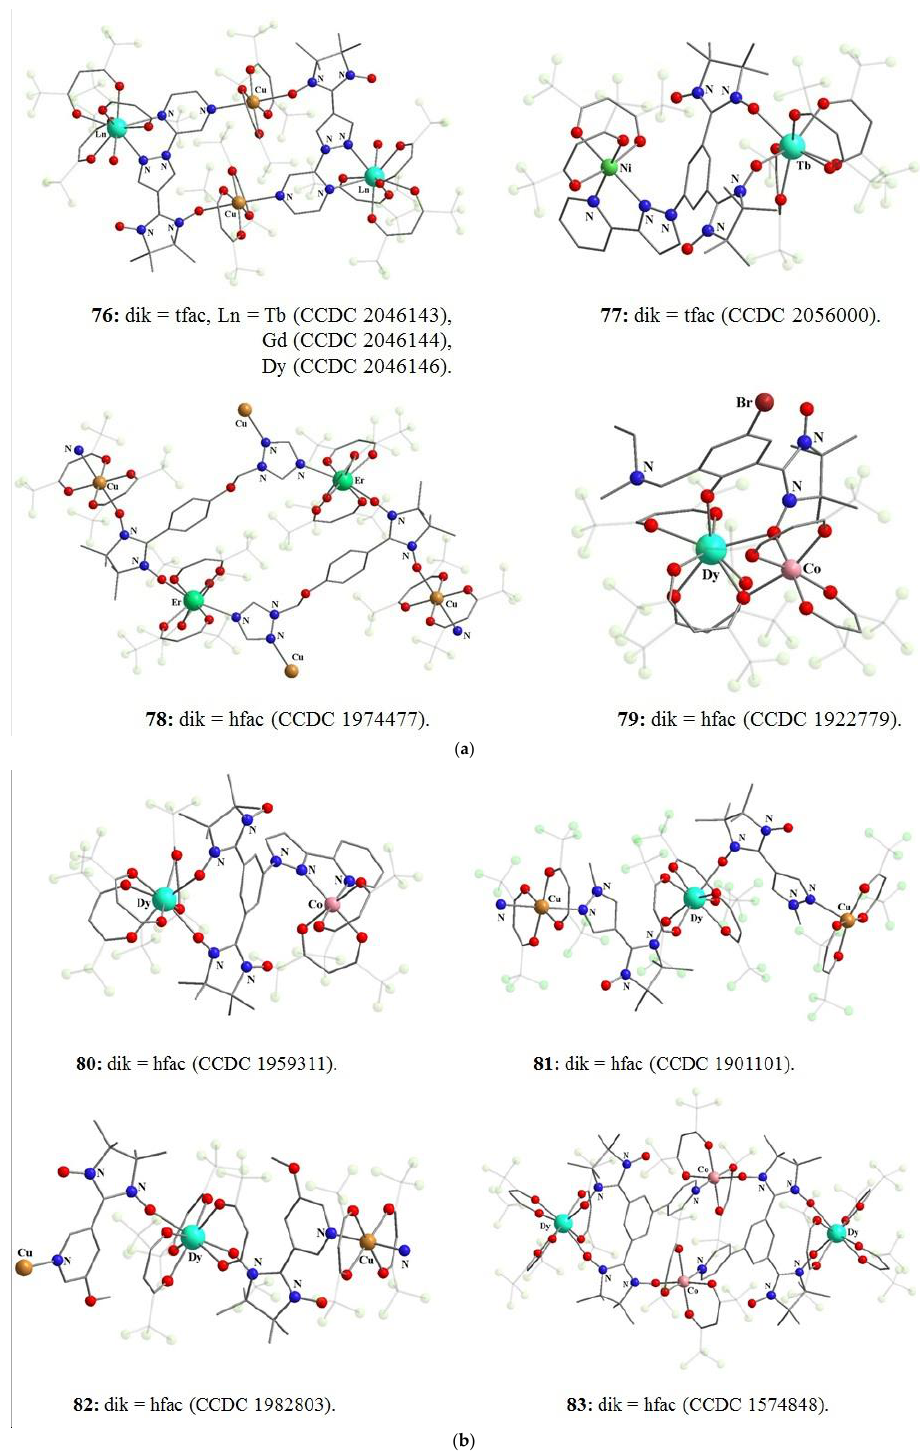
Figure 37. ( a )The examples of 3d/4f complexes containing Ln(III) tris - β -diketonate fragments. CF 3 groups are transparent for clarity. The cif has been retrieved from CCDC. ( b ) The examples of 3d/4f complexes containing Ln(III) tris - β -diketonate fragments. CF 3 groups are transparent for clarity. The cif has been retrieved from CCDC [113 – 119]. 11. Heterometallic Complex Synthesis Based on hfac Transformations In general, the synthesis of mono- and polynuclear β -diketonates is realized under basic conditions to facilitate the coordination with metal ions via deprotonation of the initial β -dicarbonyl compounds. Along with this, in some cases the base action provokes the β -diketone participation in the hydration process, retro-Claisen reaction or template transformations to form the metal complexes including tfa or ttpt as coligands [81,102,120 – 130]. A strong base used in the formation of a β -diketonate anion caused the destruction or transformation of the initial β -diketone. In work [126], the deprotonation with sodium hydroxide resulted in two possible routes of the retro-Claisen reaction (Scheme 30). Sur- prisingly, in the presence of two different carboxylates, a tetranuclear [Eu-Na] complex ( 84 ) was formed, including the β -diketonate anions and tris (3,5-dimethyl-1-pyrazolyl)me- thane (tpm) (Figure 38). The main phosphorescence characteristics were determined for the complex 84 : the observed lifetime was 0.68 ms with a quantum yield of 39% and quan- tum efficiency equal to 58% [126].